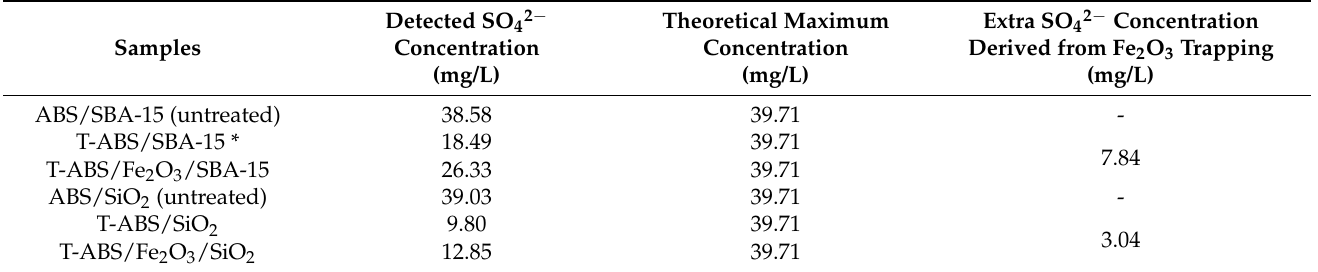
Table 1. The measured concentrations of SO 42 − using ion chromatography for the varied samples.